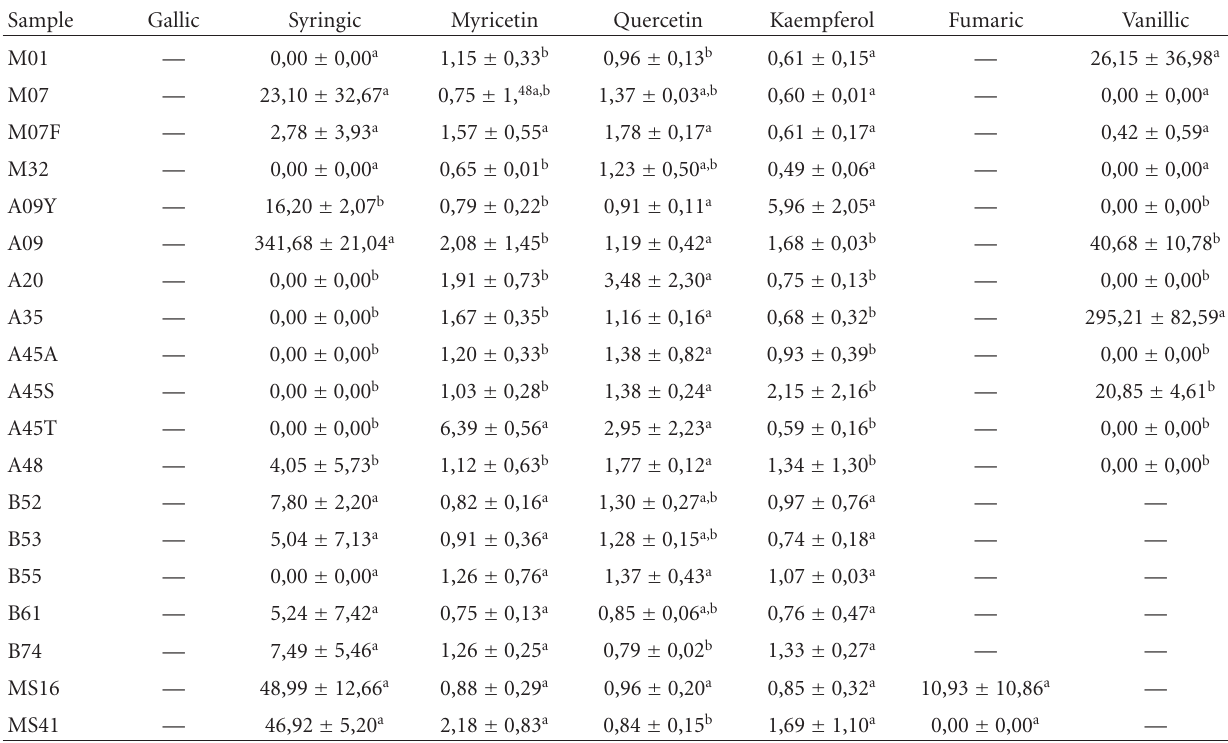
Table 5: Phenolic content of fresh nettle